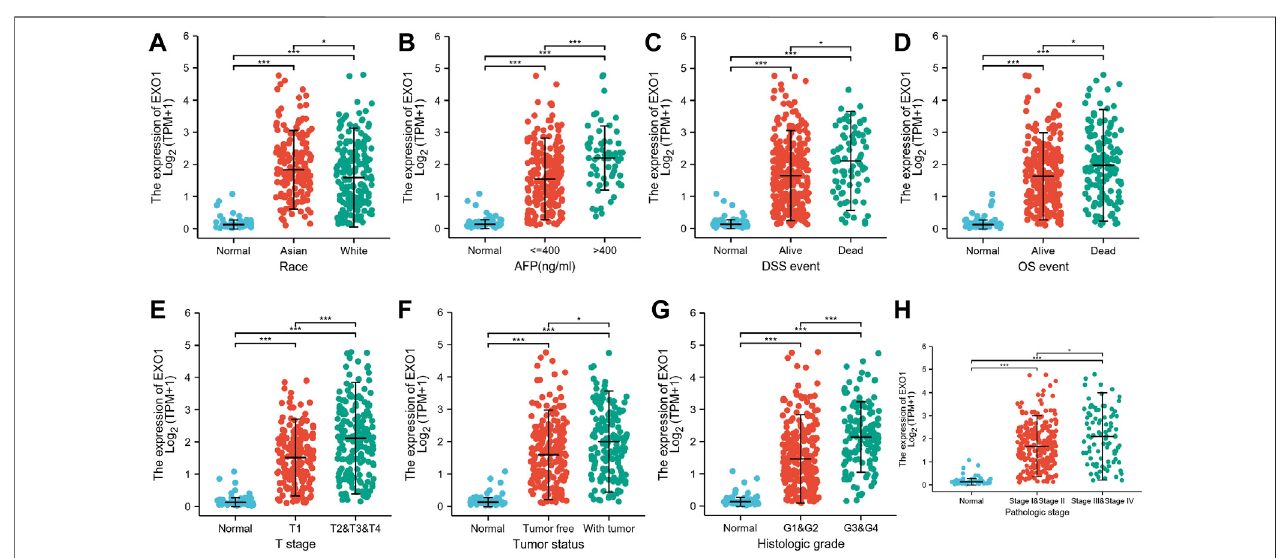
FIGURE 7 | EXO1 expression levels correlate with multiple clinicopathological characteristics of HCC patients. (A – H) The correlation analysis between EXO1 expression levels and (A) race, (B) AFP levels, (C) DSS, (D) OS, (E) T stages, (F) tumor status, (G) histologic grades, and (H) pathologic stages of HCC patients. * p < 0.05, *** p <